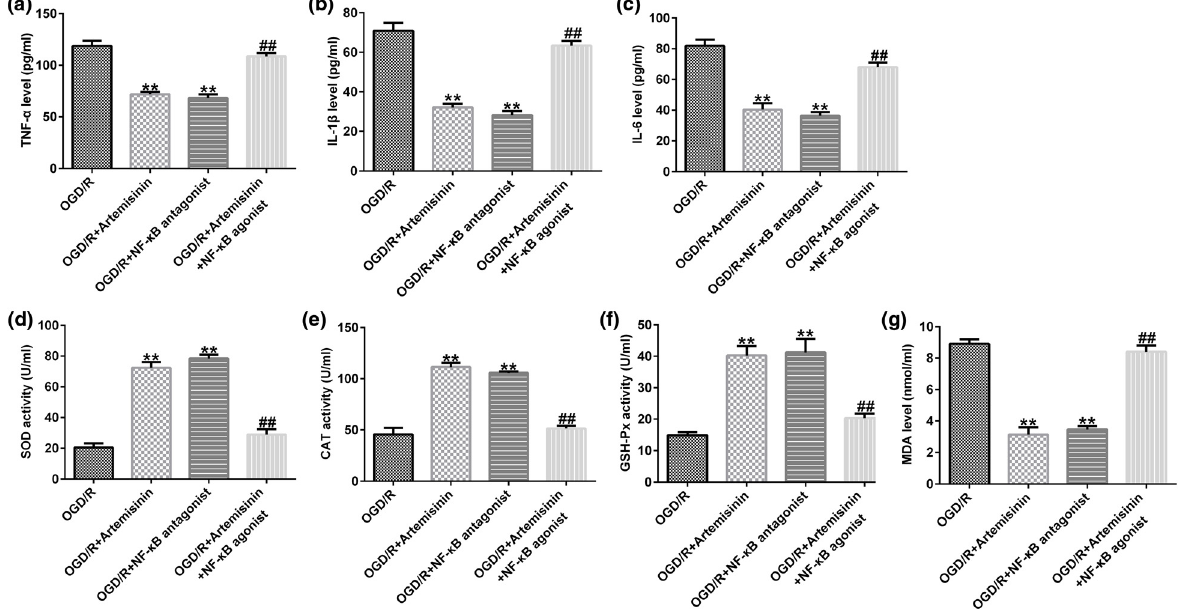
Figure 7: NF - κ B agonist reverses the e ff ects of ART on in fl ammation and oxidative stress of SH - SY5Y cells triggered by OGD/R exposure. SH - SY5Y cells were pre - treated with 100 μ M ART, an NF - κ B antagonist, or 100 μ M ART + NF - κ B agonist for 2 h and then exposed to OGD/R. ( a – c ) ELISA was used to determine the secretion of TNF - α , IL - 1 β , and IL - 6 in the supernatant of SH - SY5Y cells. ( d – g ) Activities of SOD, CAT, and GSH - Px and the level of MAD were determined. ** p < 0.01 vs OGD/R; ## p < 0.05, 0.01 vs OGD/R +